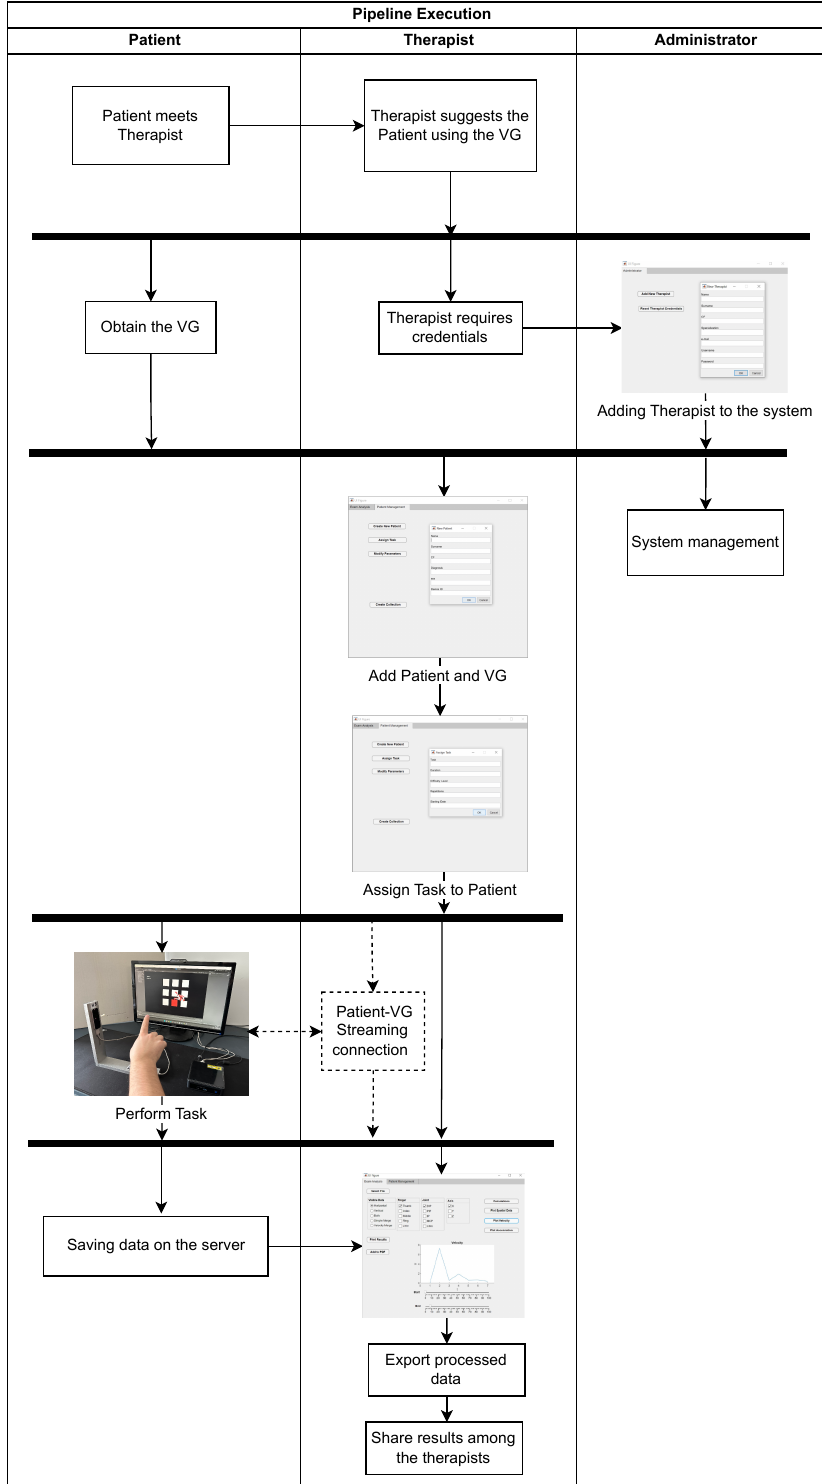
Figure 7. Swim lane diagram showing the pipeline’s execution. The pipeline describes the rehabilita- tion process, from the beginning when the Patient is suggested to use the VG, until data are processed and shared among therapists. Obviously, the process can be continued by the Therapist, assigning a new task or updating the task’s difficulty, or restarting with a new